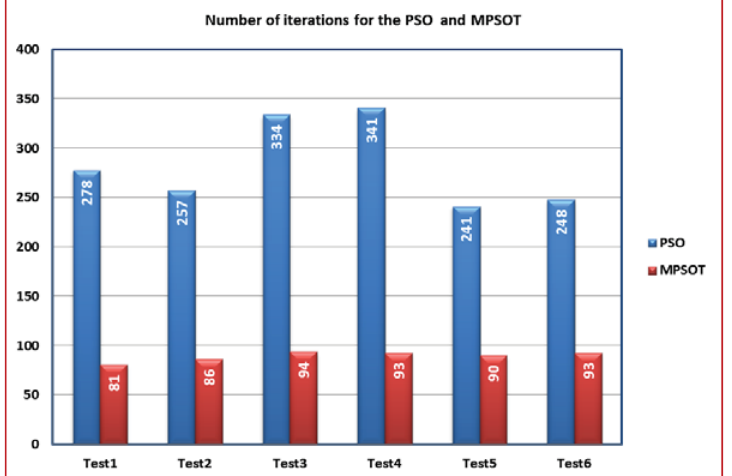
Figure 10. A comparison between the numbers of iterations in case of using the basic PSO and MPSOT in 3-D calibration.